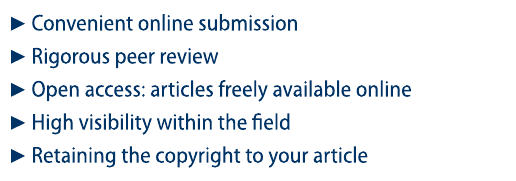
protocol. Eur J Cancer.